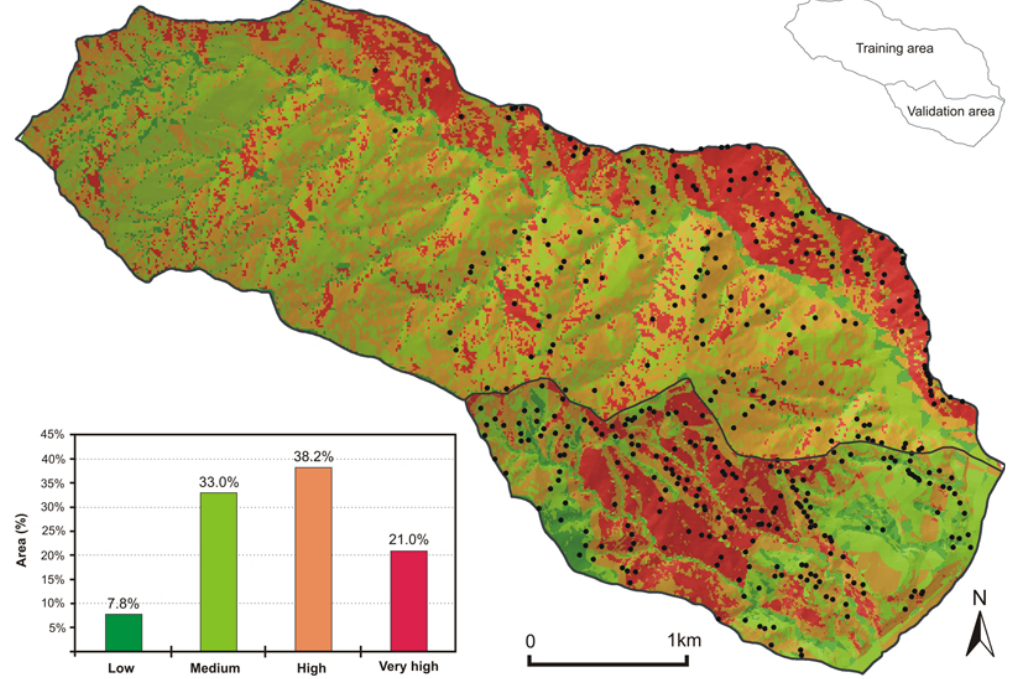
Fig. 5. Landslide susceptibility map subdivided in four landslide susceptibility classes: green, low susceptibility; light green, medium sus- ceptibility; orange, high susceptibility; red, very high susceptibility. The bars show the percentage area within the different landslide suscep- tibility classes; black dots indicate the location of the